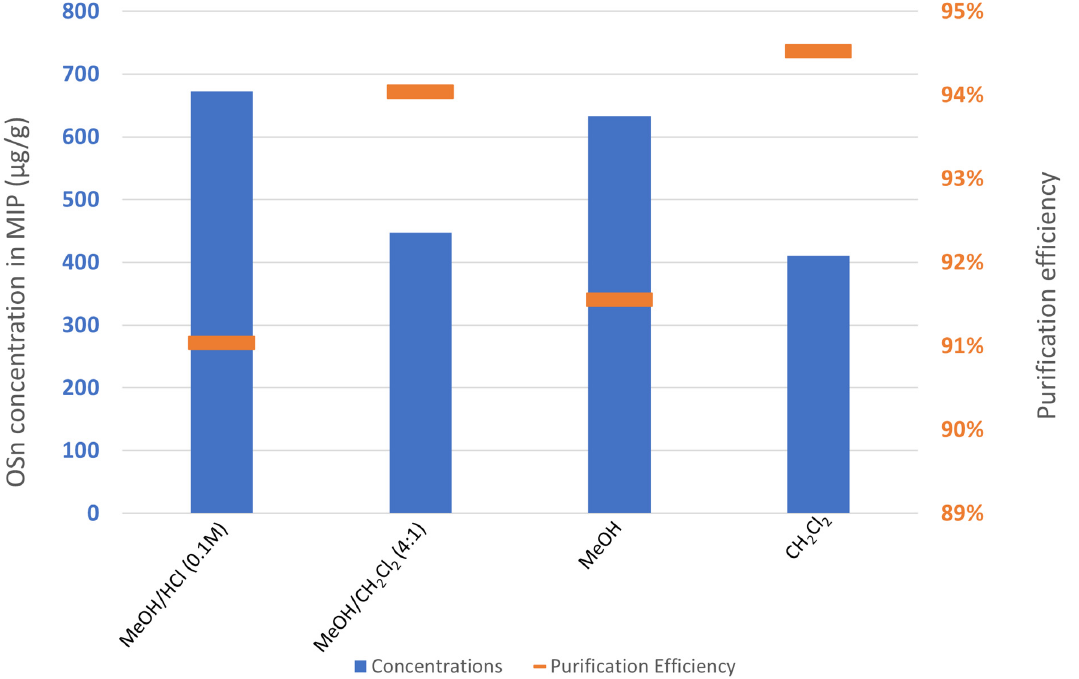
Figure 6. OSn concentrations remaining in the extracts of bulk synthesized MIP after washing steps and its respective removal efficiencies.